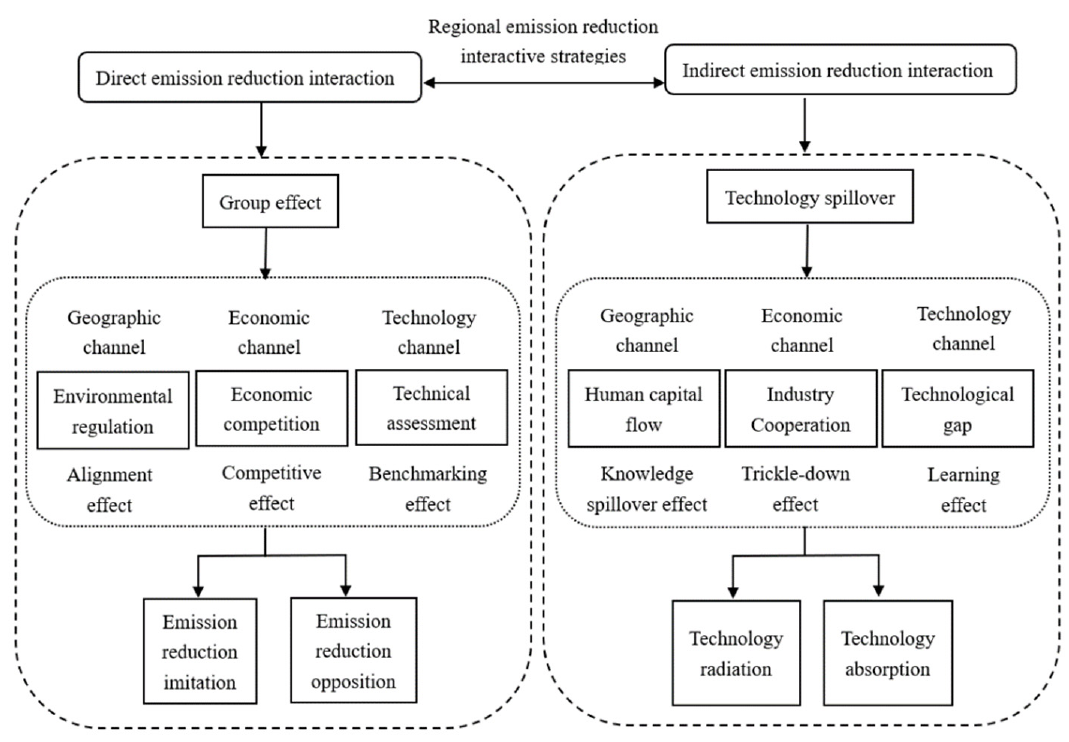
Figure 1. Strategic framework for regional coordinated emission reduction.